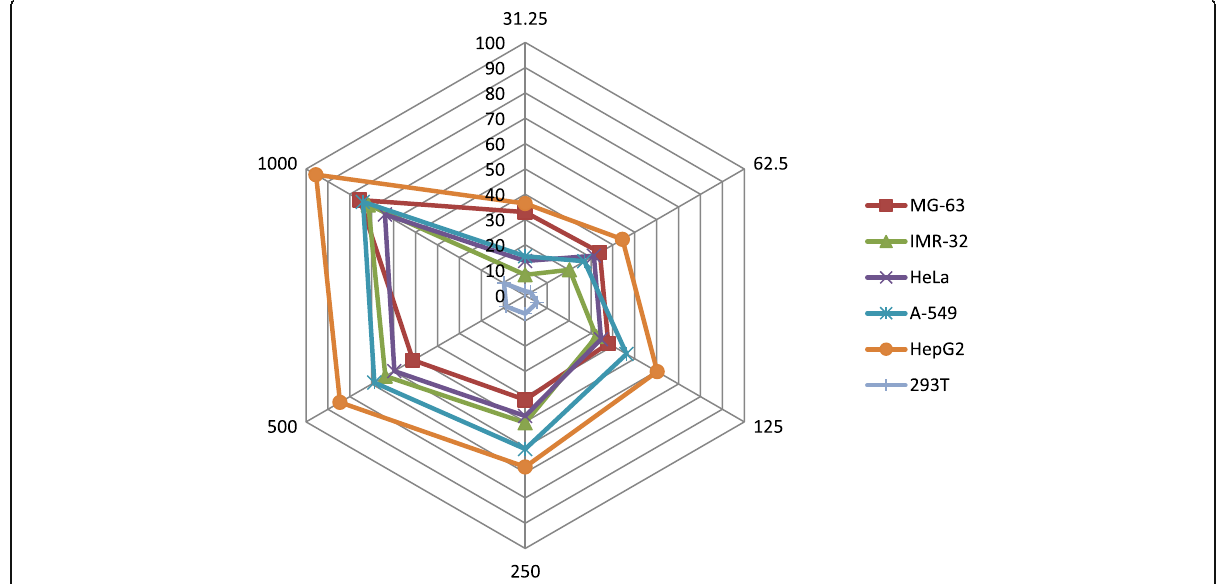
Fig. 3 Radial graph of growth inhibitory activity of herbal combination against different human cell